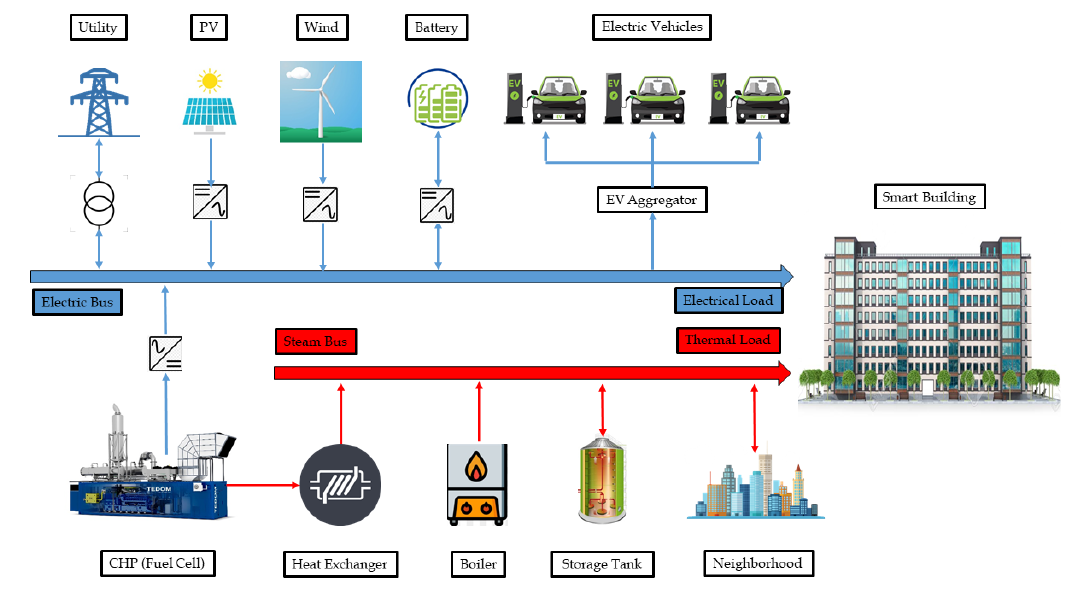
Figure 1. Overview of a smart